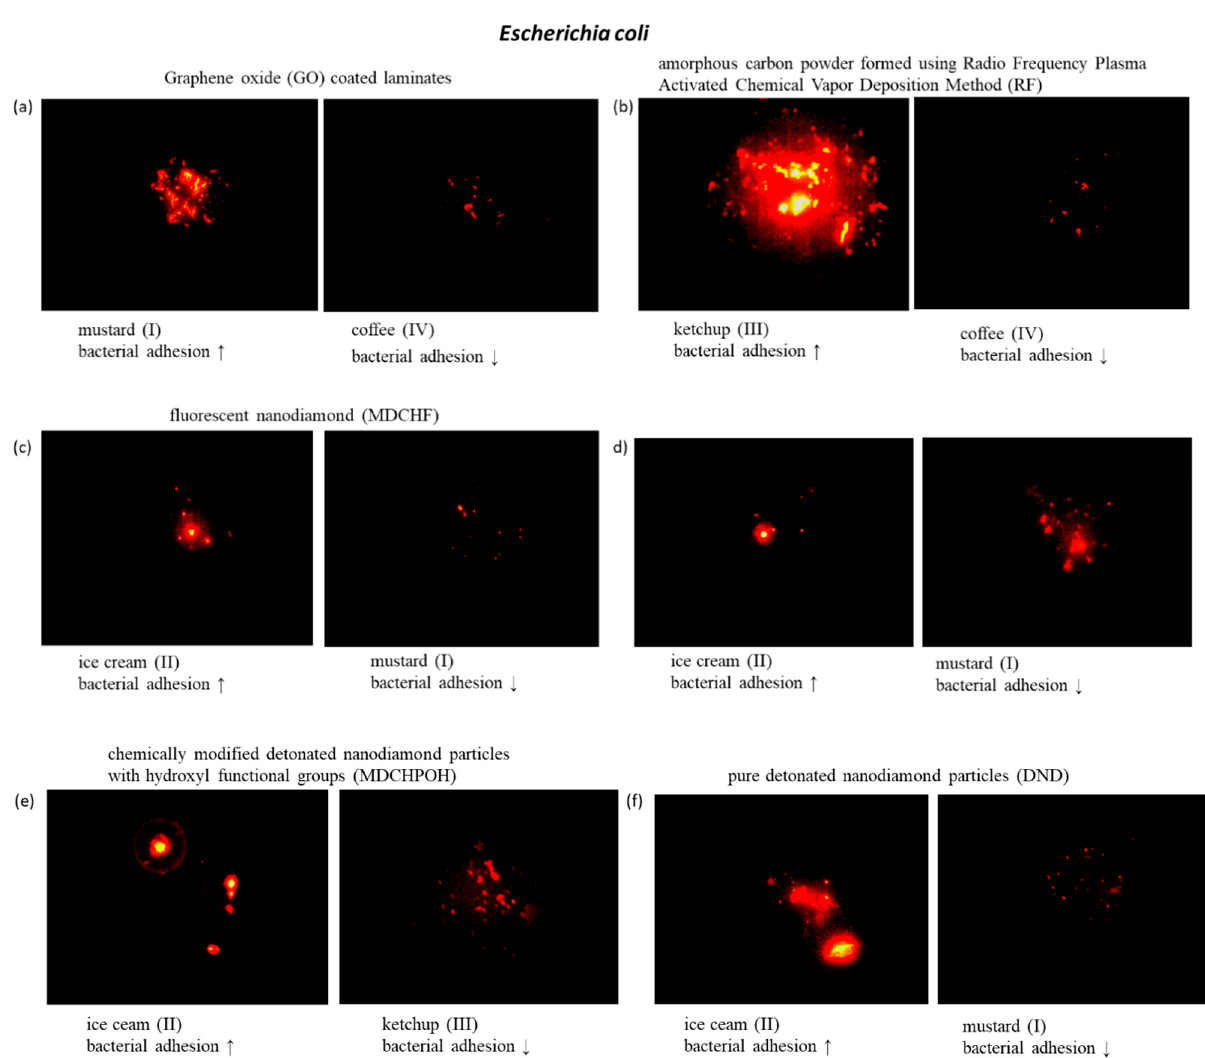
Figure 16. Images of Escherichia coli adhesion to laminates food I—mustard, II—ice cream, III—ketchup, IV—coffee, with the lowest and highest adhesion to layers formed by: ( a ) Graphene Oxide (GO) film; ( b ) amorphous carbon powder formed using Radio Frequency Plasma Activated Chemical Vapor Deposition Method (RF); ( c ) fluorescent nanodiamond (MDCHF); ( d ) plasma–chemically modified detonated nanodiamond particles (MDP1); ( e ) chemically modified detonated nanodiamond particles with hydroxyl functional groups (MDCHPOH); ( f ) pure detonated nanodiamond particles (DND).